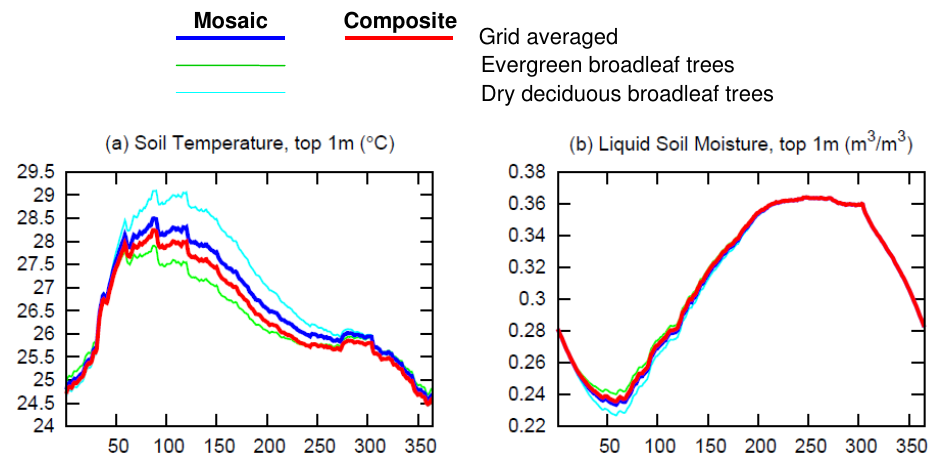
Figure 7. Simulated daily average values of (a) soil temperature and (b) soil moisture for the Africa location. The blue and red lines represent grid-averaged values for the mosaic and composite approaches, respectively. The green and cyan lines represent values for the evergreen broadleaf tree and dry deciduous broadleaf tree mosaic tiles in the mosaic approach, respectively.